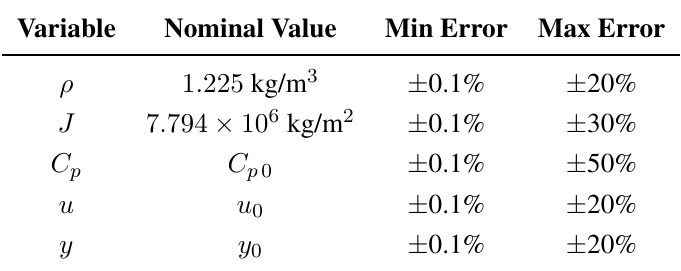
Table 6. Realistic wind turbine